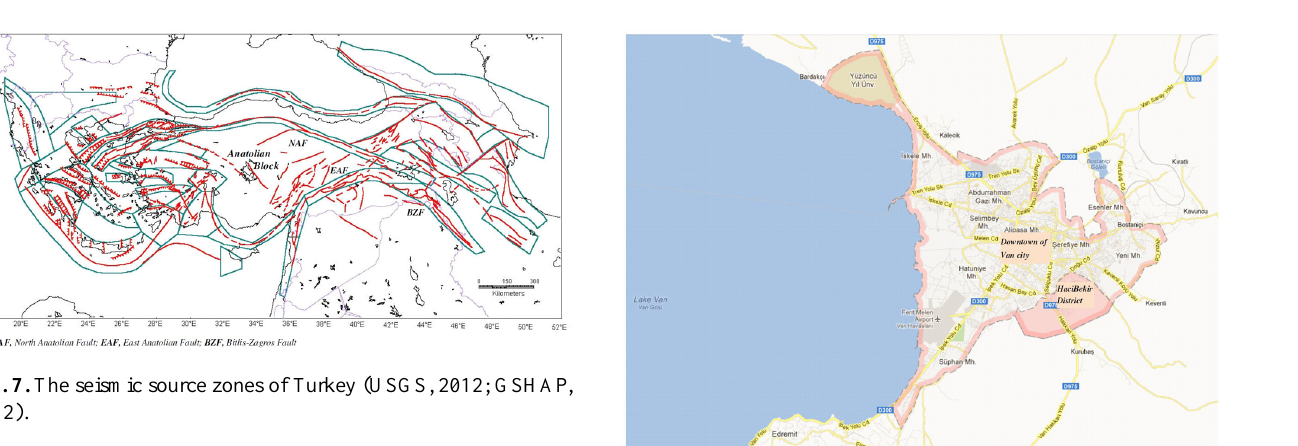
Fig. 6. The historical seismicity of the Van region (USGS, 2012).